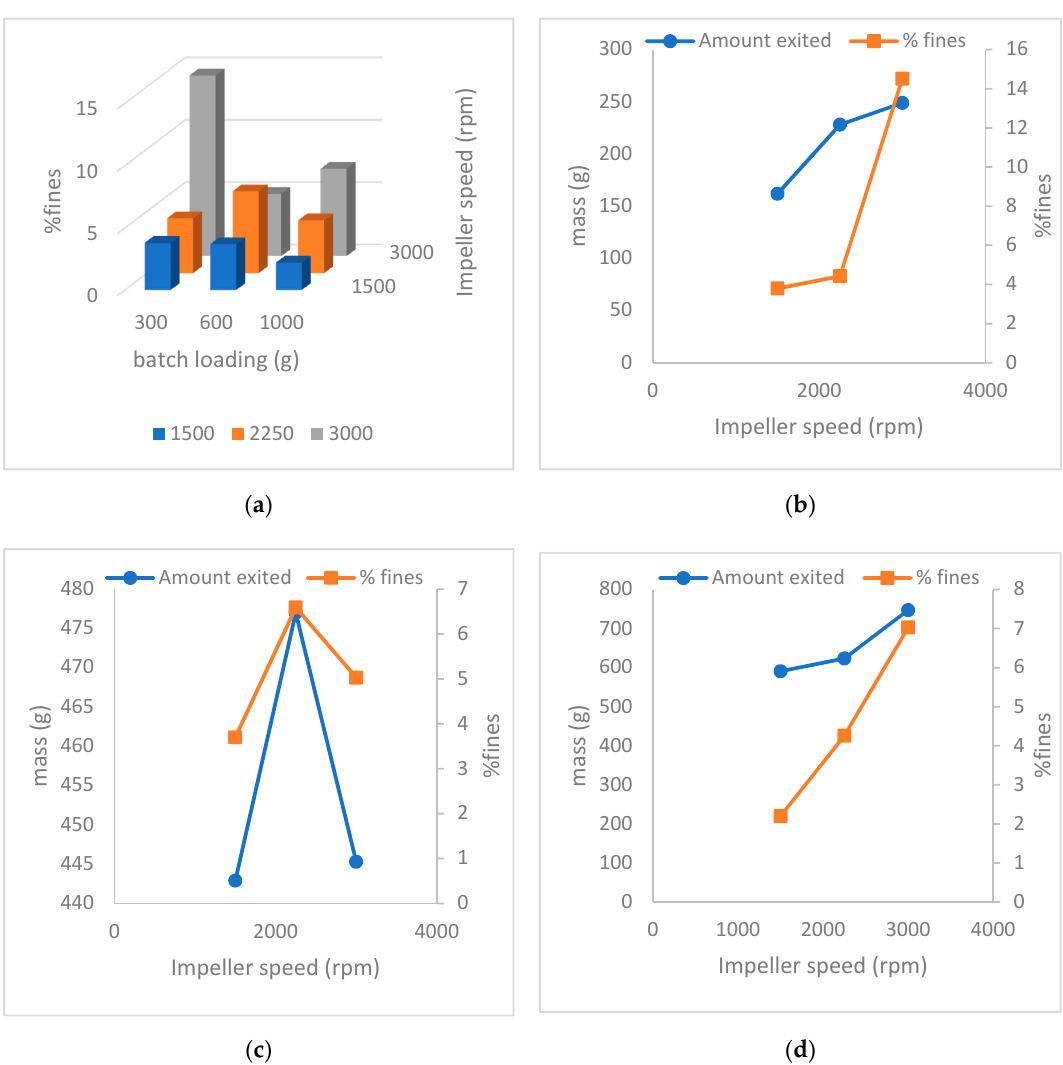
Figure 3. ( a ) %fines obtained for each run, comparison between mill throughput and %fines at a batch loading of ( b ) 300 g, ( c ) 600 g and ( d ) 1000 g.